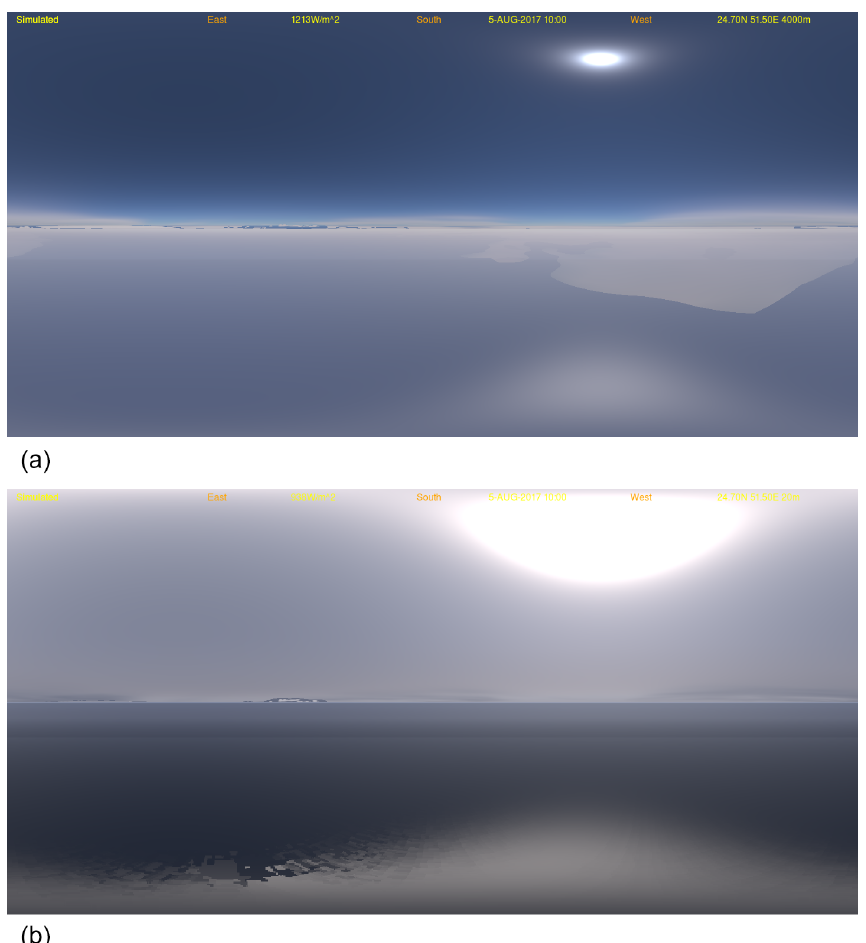
Figure 9. RAMS model simulation view from (a) 4km and (b) 20m above the Persian Gulf showing dust, hydrometeors, land surface, and water including sun glint, displayed with a cylindrical (panoramic)